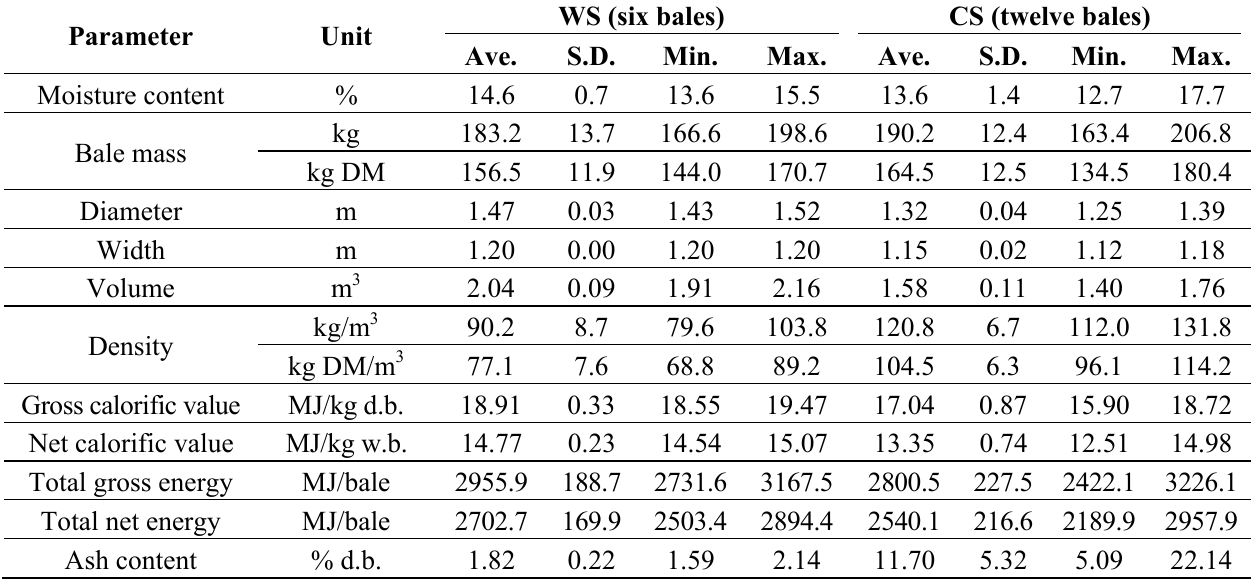
Table 1. Characteristics of wheat straw (WS) and corn stover (CS) bales measured in the